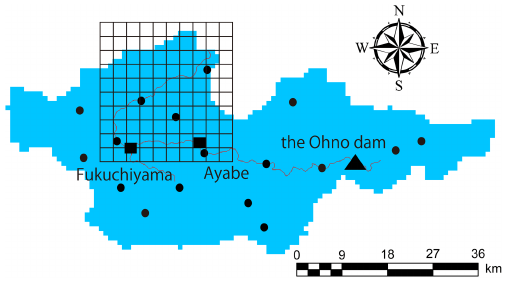
Figure 2. The Yura-gawa river basin and the locations of dis- charge gauges and rainfall gauges (inundation is simulated in the shaded area; rectangulars are discharge gauges; small circles are rain gauges; and a triangle is the Ohno dam).